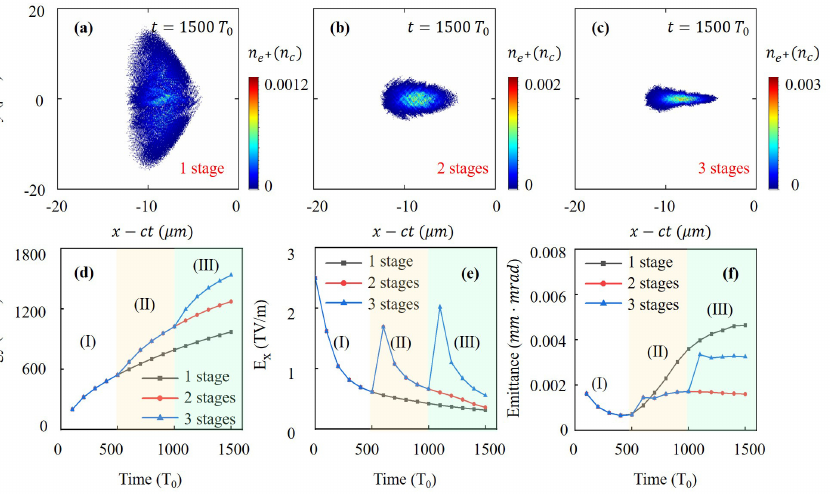
Figure 7. Positron density distribution at t = 1500 T 0 after ( a ) one ( b ) two and ( c ) three acceleration stages. Time variation of ( d ) positron energy, ( e ) acceleration gradient and ( f ) beam emittance at different acceleration stages.